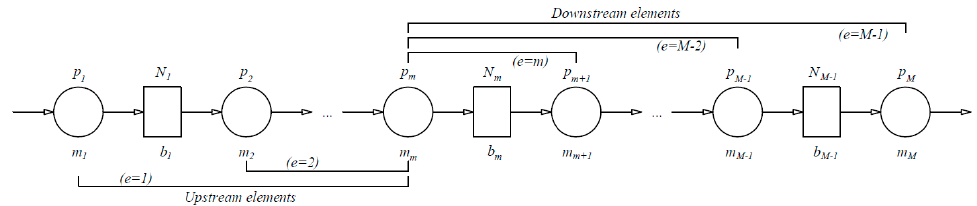
Figure 2. Distribution of the finite-state elements along the serial Bernoulli production line (reproduced according to [9].